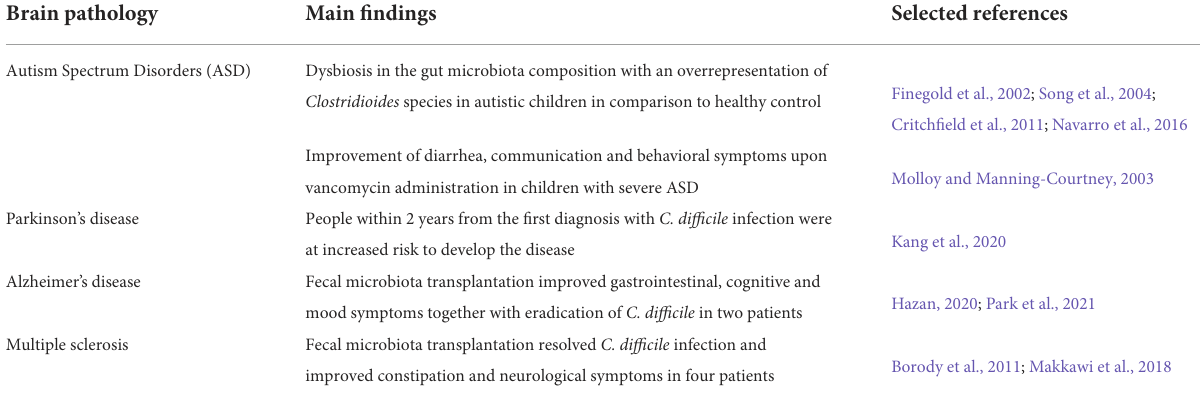
TABLE 1 Summary of the studies related to the potential involvement of C. difficile in brain